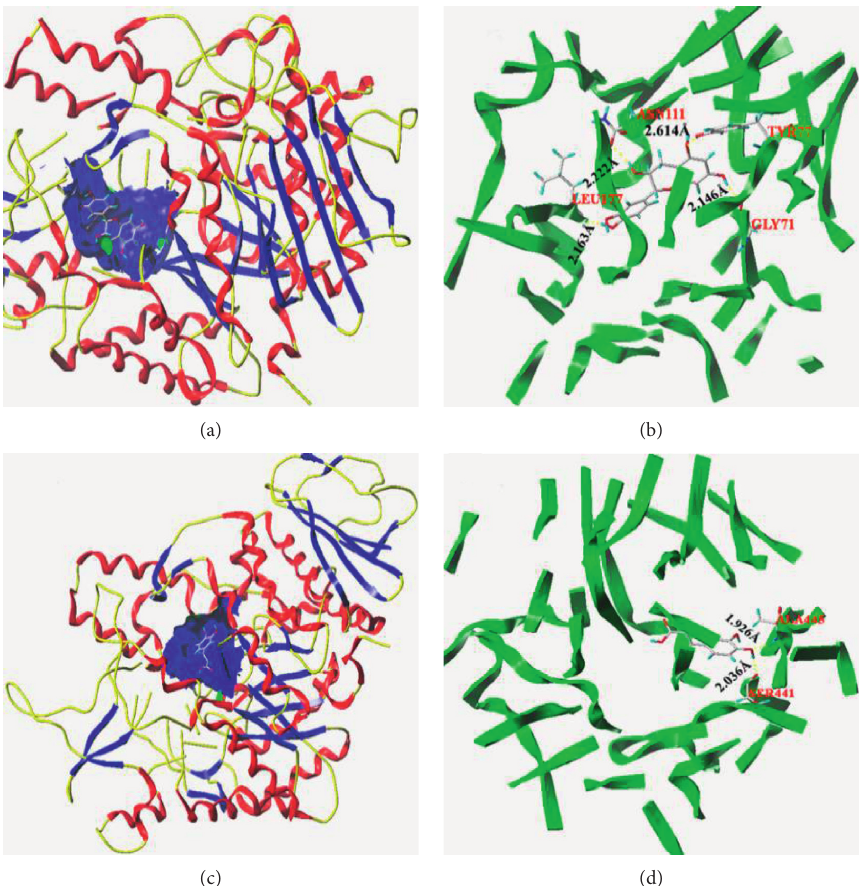
Figure 4: The molecule docking results of catechin and caffeic acid with α -glycosidase. (a) Catechin binds with the active site of α -glucosidase. (b) Catechin interacts with amino acid residues. (c) Caffeic acid binds with the active site of α -glucosidase. (d) Caffeic acid interacts with amino acid residues. Two phenolic standards appeared in ball and stick models, amino acid residues are represented by green capped stick models, and short dotted yellow line stands for hydrogen